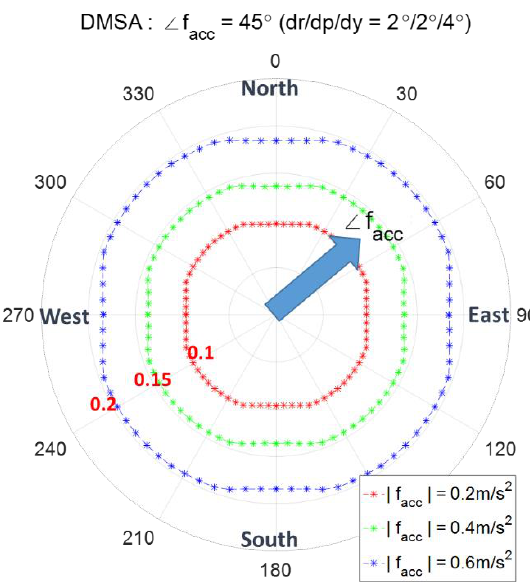
Figure 17. Combined contour of DMSA with respect to the magnitude of ∠𝐟 𝐚𝐜𝐜 = 45 °.